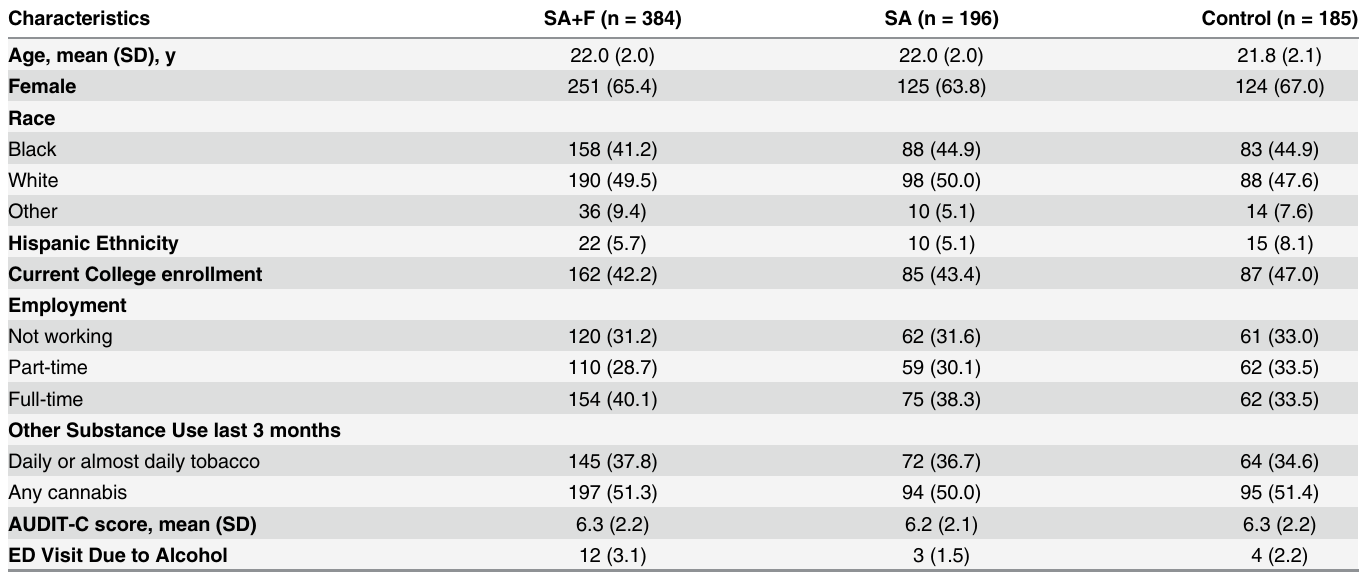
Table 1. Baseline sample